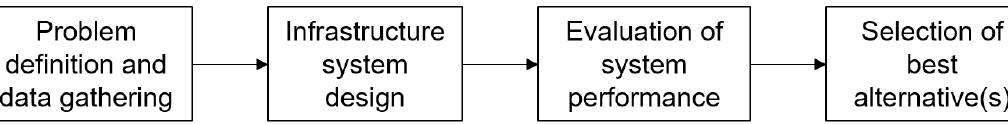
Figure 10. Comprehensive assessment framework for stormwater harvesting alternatives provided by Dandy et al.